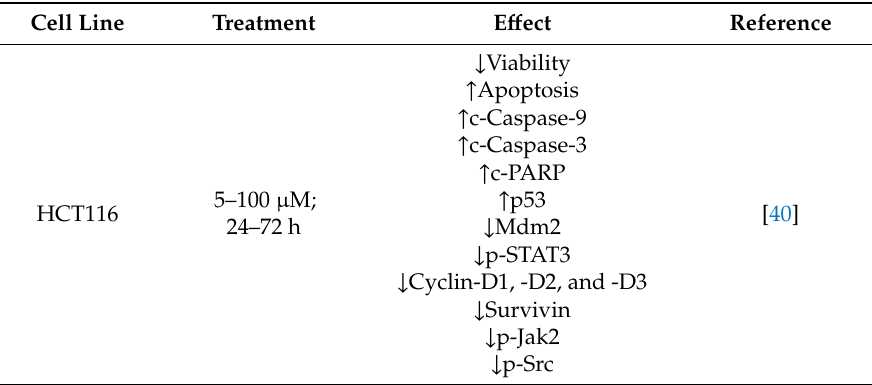
Table 2. E ff ects of carnosol on colon cancer in